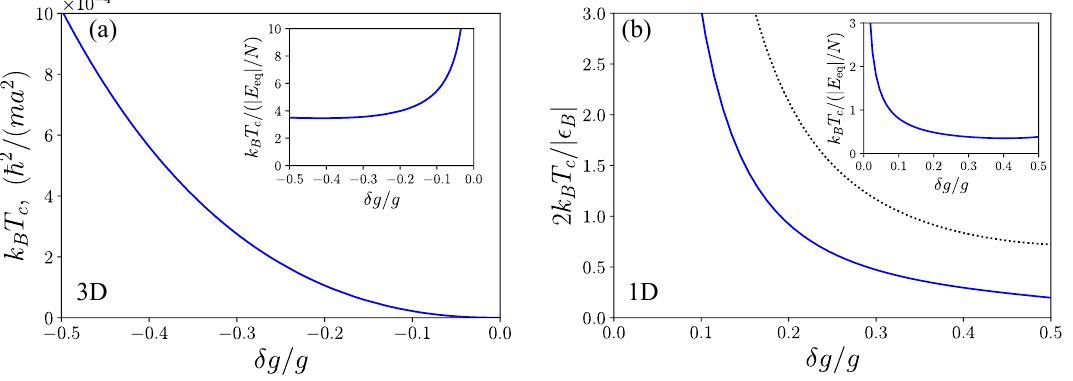
Figure 9: Critical temperature for the dynamical stability of the liquid phase, in (a) 3D and (b) 1D geometry. The inset shows the ratio of the critical temperature to the ground state energy of the liquid phase. In panel (b) the blue solid line is the prediction from our theory, whereas the black dotted line is the calculation using the Bogoliubov speed of sound Eq.